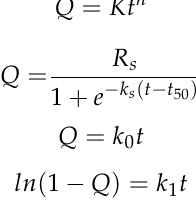
Figure 5. Cumulative release of insulin from the DOP/PEI − PBA hydrogel at different glucose levels ( A ) and pH ( B ). CD spectra of standard and released insulin ( C ).